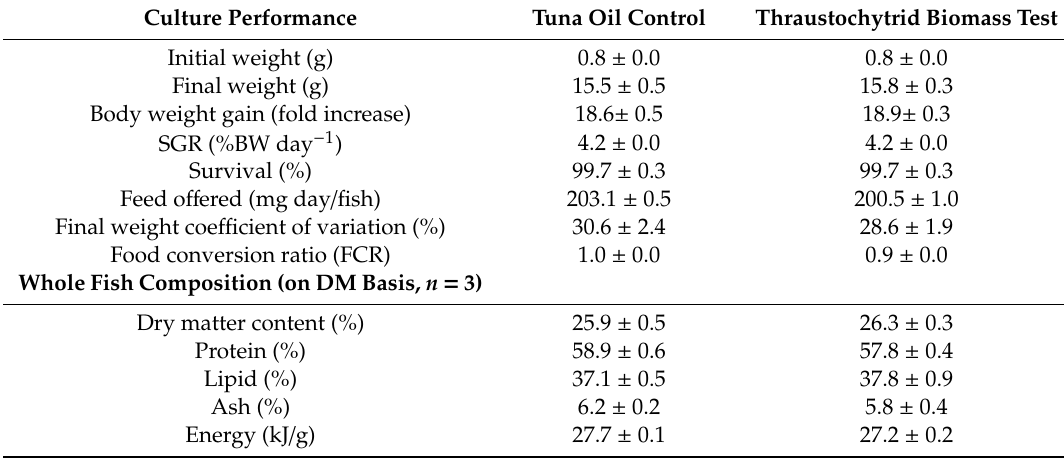
Table 2. Summary of culture performance and whole fish composition after 70 days of culture. No significant di ff erence was found ( t -tests, p > 0.05).